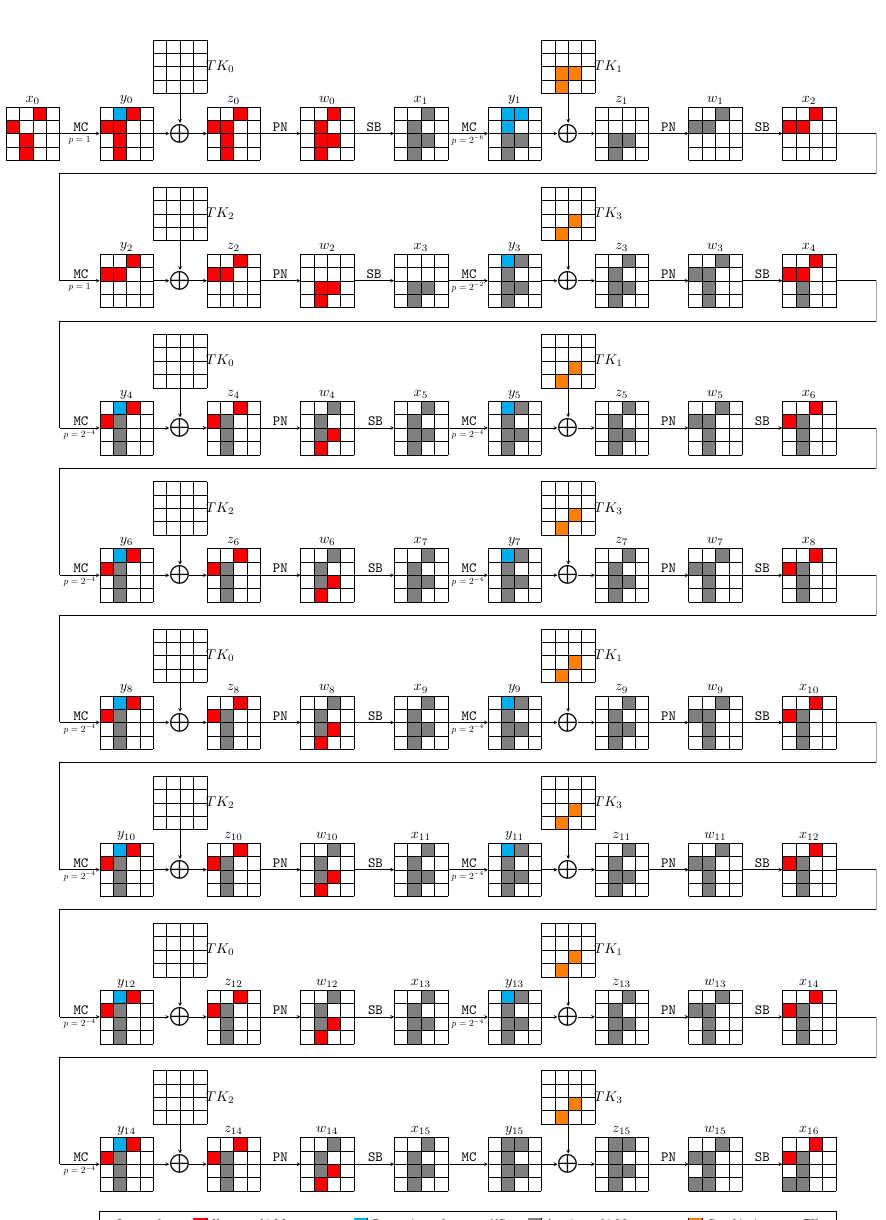
Figure 17: A 16-round Conjectural Distinguisher of